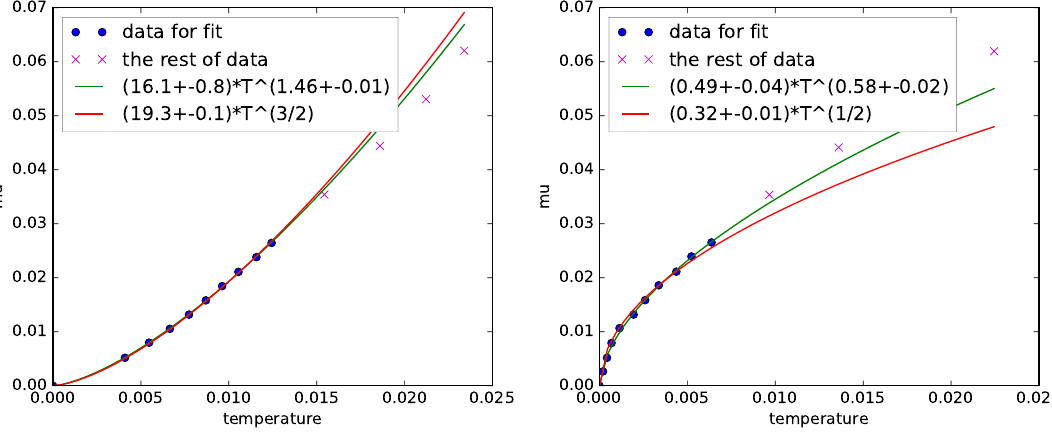
Figure 4 . The fit for T WH using the numerical data from [9] in figure 3. The fit is consistent with the analytical prediction µ ∼ T 3 / 2 . We im- posed a cut-off µ < 0 . 03 .